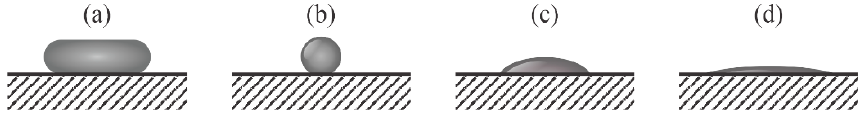
Figure 2. Illustration of the degree of surface hydrophilicity. A large droplet will form an oval-like shape on a superhydrophobic surface ( a ); a small water droplet will form a perfect sphere on a superhydrophobic surface ( b ); a typical shape of a small water droplet on a hydrophilic surface ( c ); a small water droplet on a superhydrophilic surface ( d ). Not to scale.